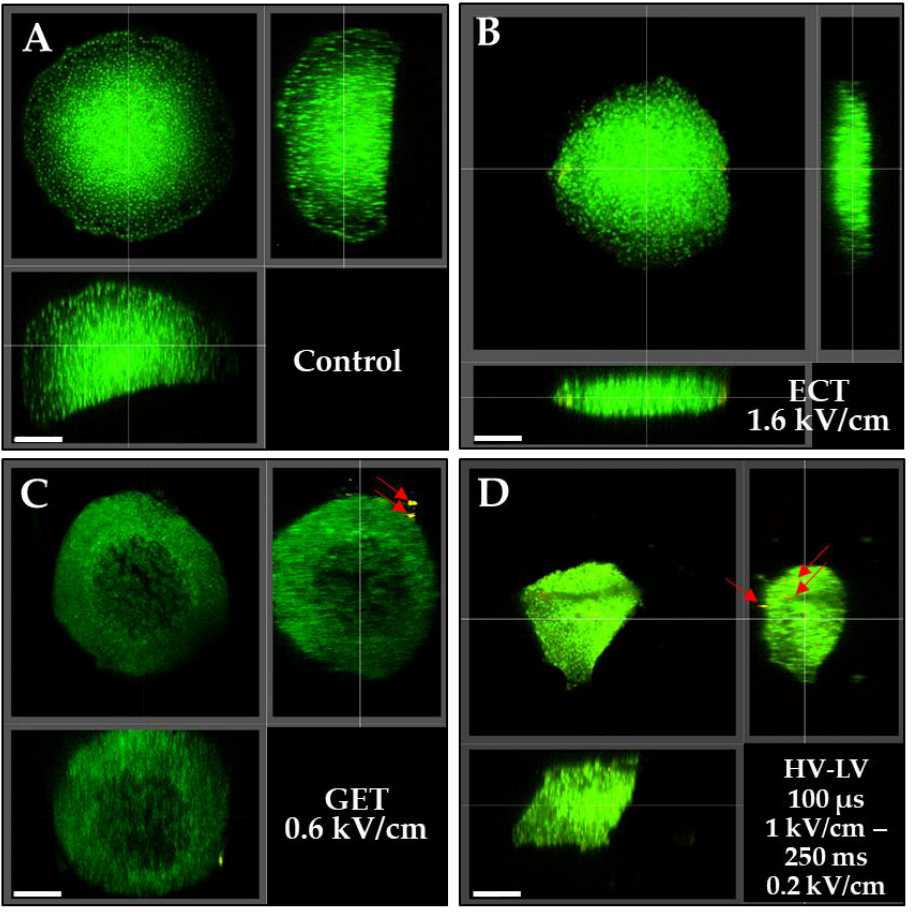
Figure 9. Representative 3D fluorescence micrographs of clarified HCT-116 GFP spheroids after gene electrotransfer. Spheroids were incubated with 40 µ g/mL plasmid encoding tdTomato and no treated ( A ), or treated with ECT pulse parameters (8 impulsions of 100 µ s, 1.6 kV/cm at 1 Hz) ( B ), GET pulse parameters (10 pulses of 5 ms, 0.6 kV/cm at 1 Hz) ( C ) and HV-LV pulse parameters (100 µ s at 1 kV/cm—250 ms at 0.2 kV/cm) ( D ). Fixed spheroids were observed 24 h after pulsation. Transfected area is indicated with a red arrow. Top left: front view, top right: transversal view, up left: sagittal view of an optical plane inside the spheroid. Scale bar = 200 µ m. N = 2 independent experiments, 4 spheroids per experiment.